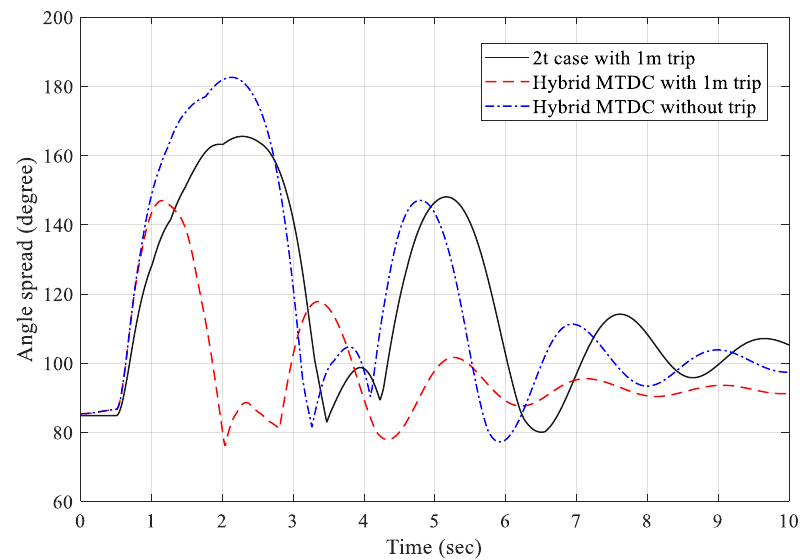
Figure 24. The system angle spread for the load side event in the actual system data.